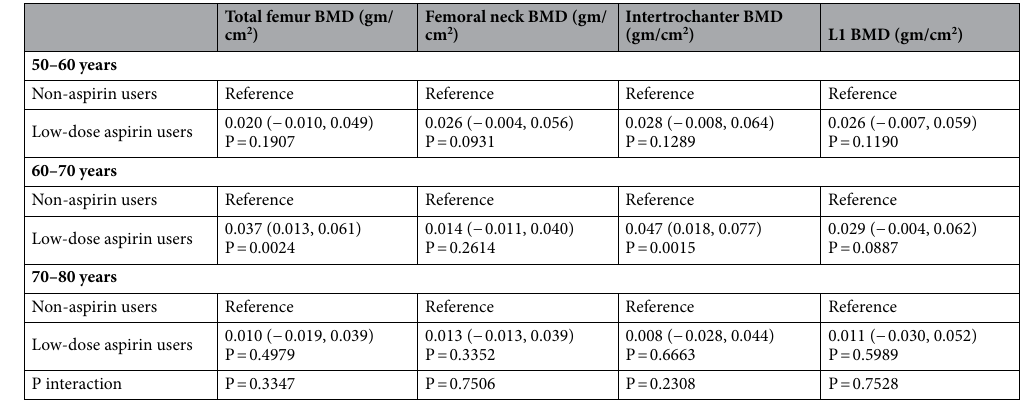
Table 4. Subgroup analyses stratified by age. Gender, Race, Heart attack, Vigorous work activity, BMI, Hba1c, Education level, Ratio of family income to poverty, Fractures, Anti-osteoporotic, Prednisone or Cortisone, HS C-Reactive Protein, Smoking status, Serum Creatinine, Serum Uric acid, Alcohol consumption were